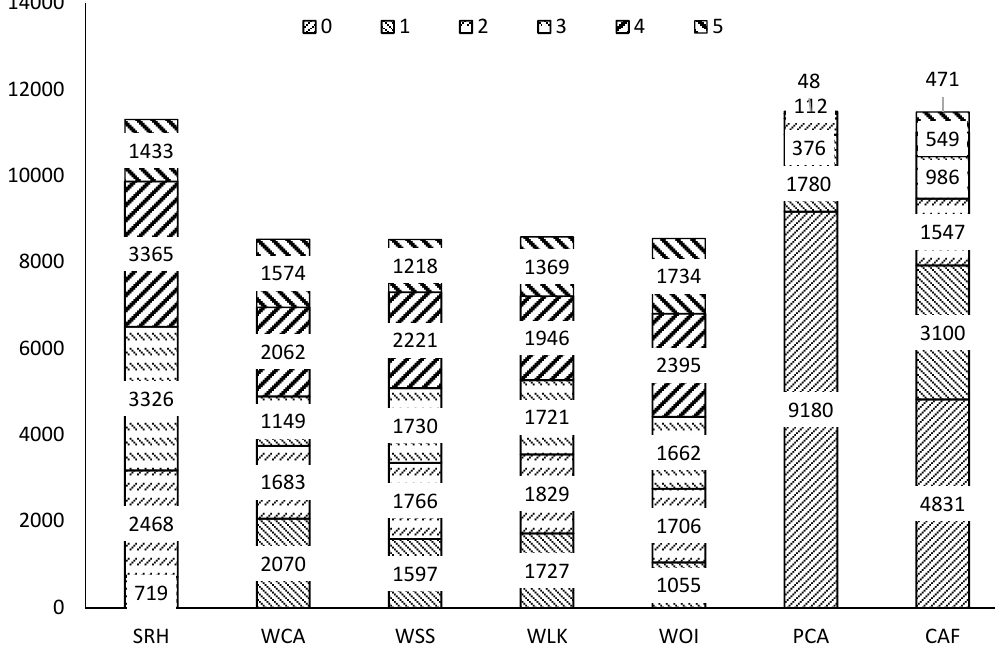
Figure 2. Column chart of six indicator variables. Note: SRH, self-rated health; WCA, willingness to